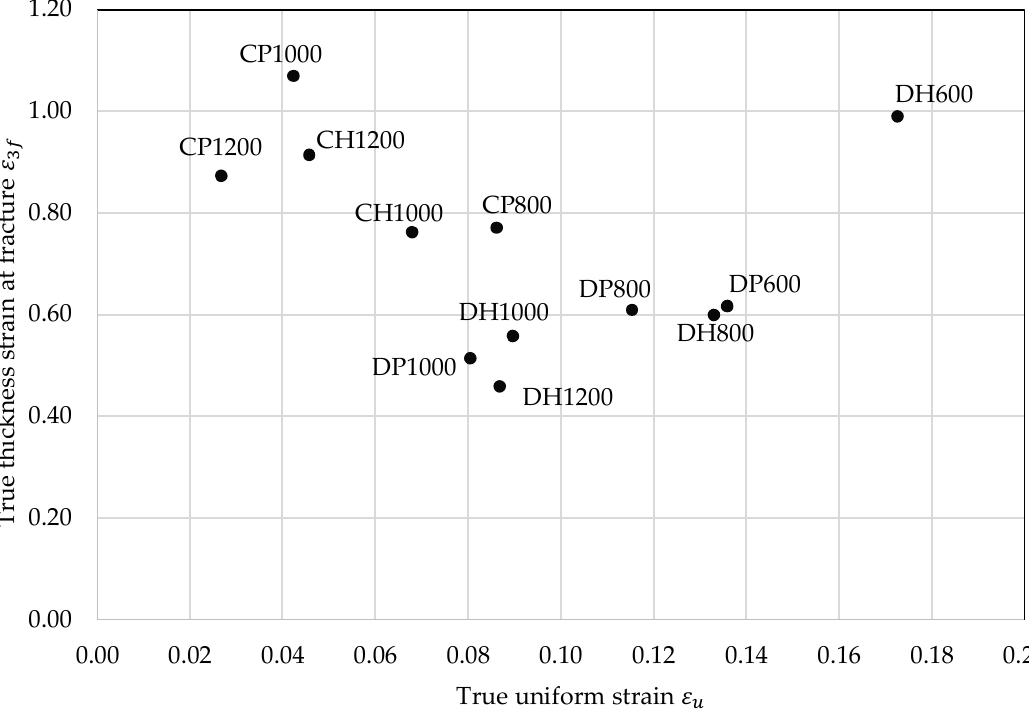
Figure 11. Global and local formability diagram: true thickness strain at fracture–true uniform strain.